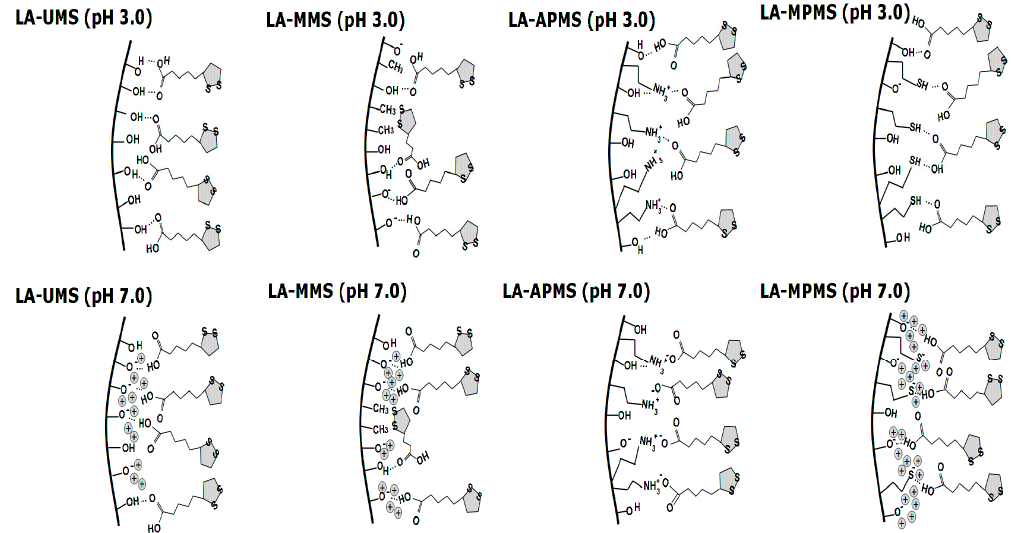
Figure 3. Scheme of possible interactions between LA and the surface of silica matrixes in synthesized.